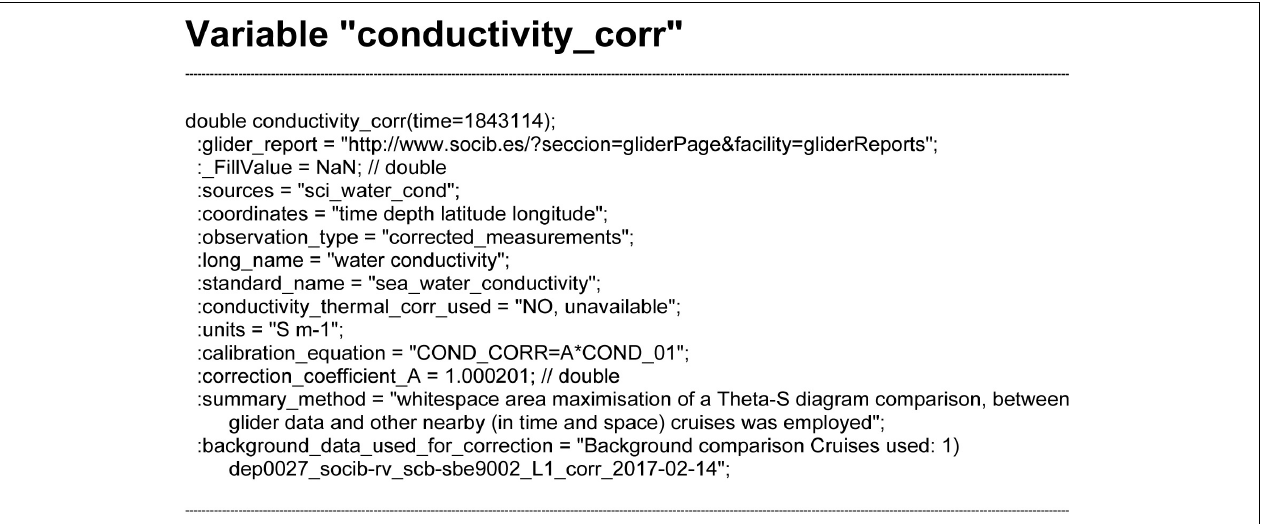
FIGURE 9 | An example of the Metadata that accompany the DM scientific corrected conductivity data in SOCIB’s Data